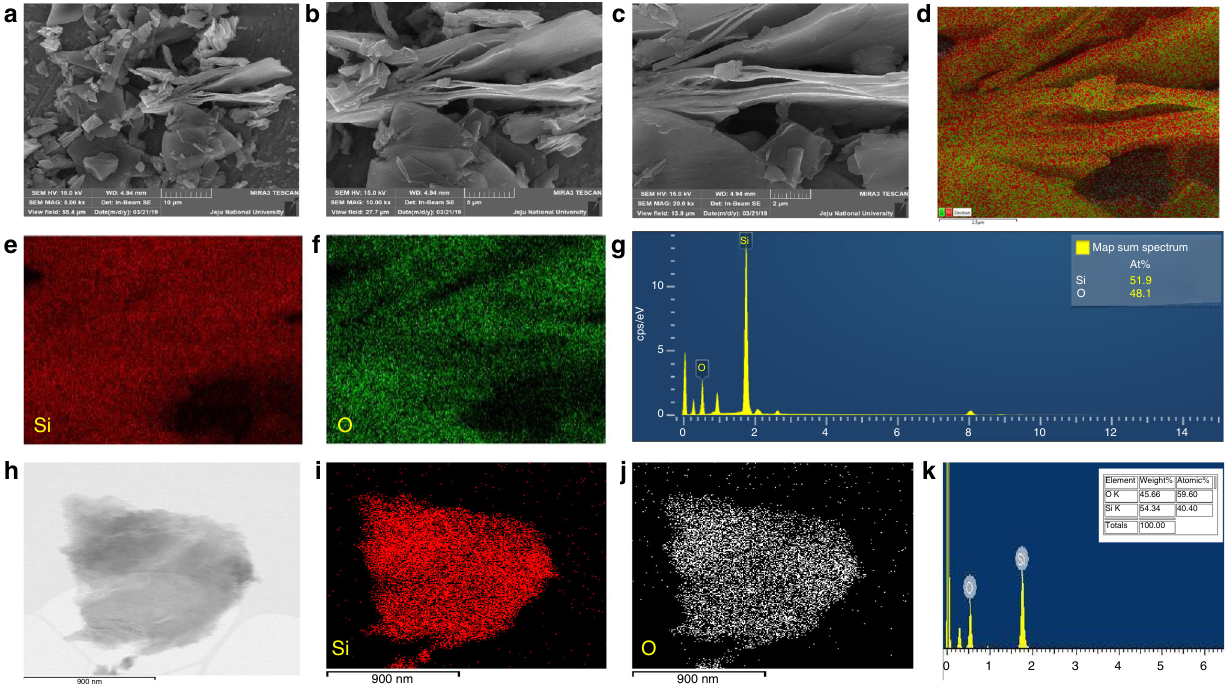
Fig. 3 Morphological and elemental analysis of siloxene sheets. a – c Field emission scanning electron micrographs of the siloxene sheets. d Elemental mapping analysis showing the overlay map and e – f EDS mapping of Si and O present in the siloxene sheets; g EDS spectrum of Si and O present in siloxene sheets; h high-resolution transmission electron micrograph of individual siloxene sheets; i , j EDS mapping of Si, and O elements present in the siloxene sheets; and k elemental composition spectrum of Si and O present in siloxene